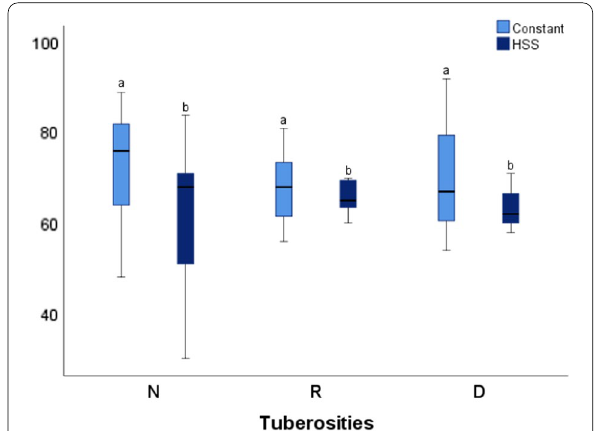
Fig. 3 Boxplot chart where we can observe function (according to Constant and HSS) in relation to the state of tuberosities. Same letters